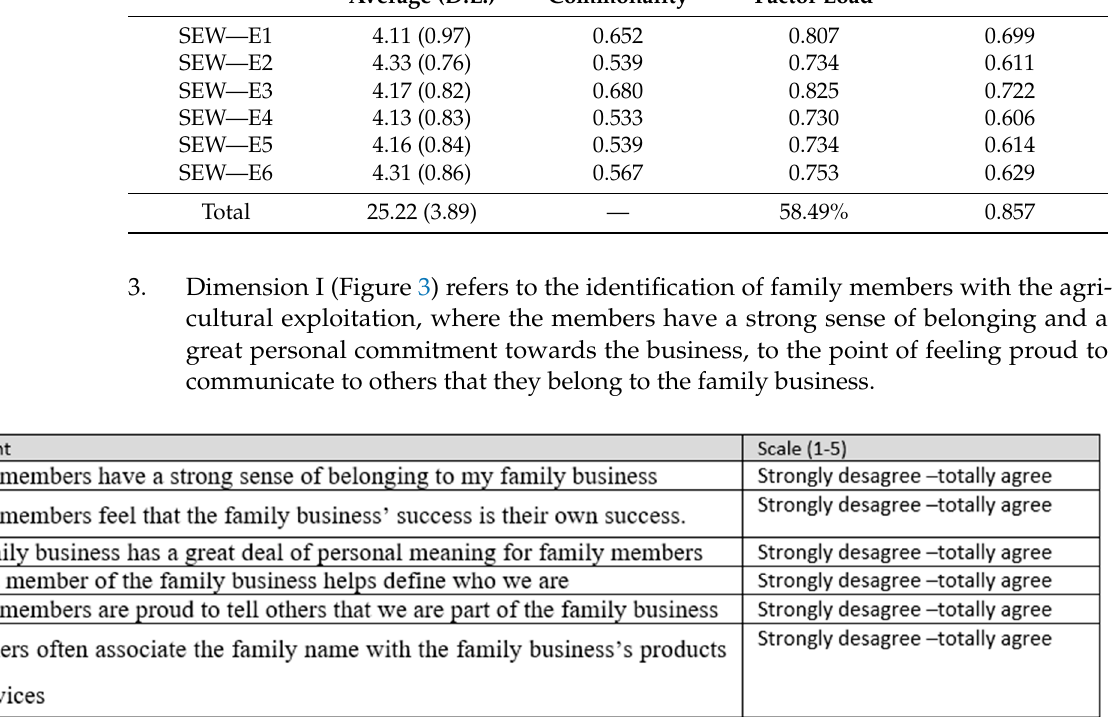
Table 3. Unidimensionality and reliability. Dimension E—Emotional Attachment of family members of the REI ( n = 156). Descriptive Factor Analysis by C.P.